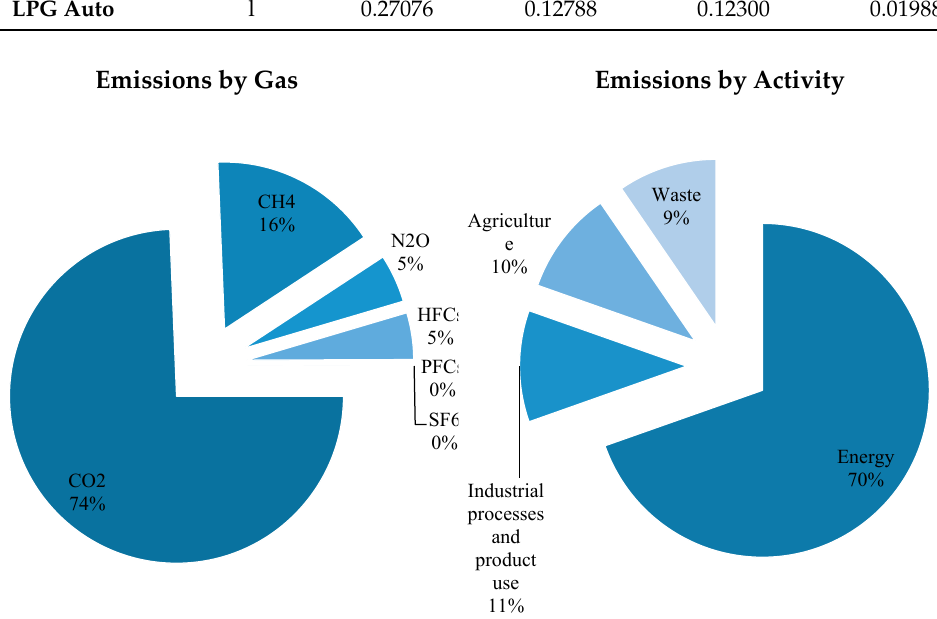
Figure 3. Greenhouse gas emissions.